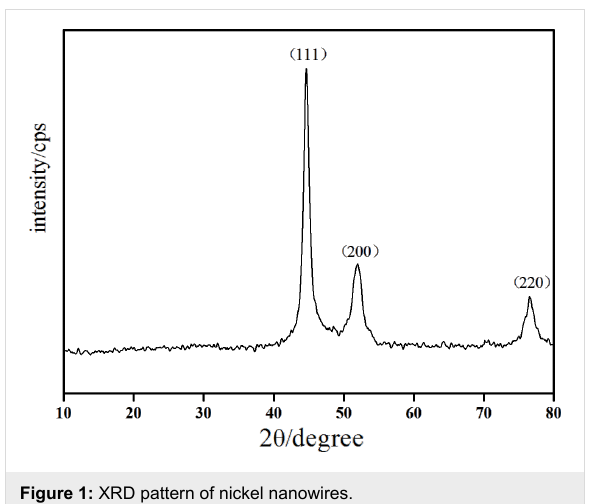
Figure 1: XRD pattern of nickel